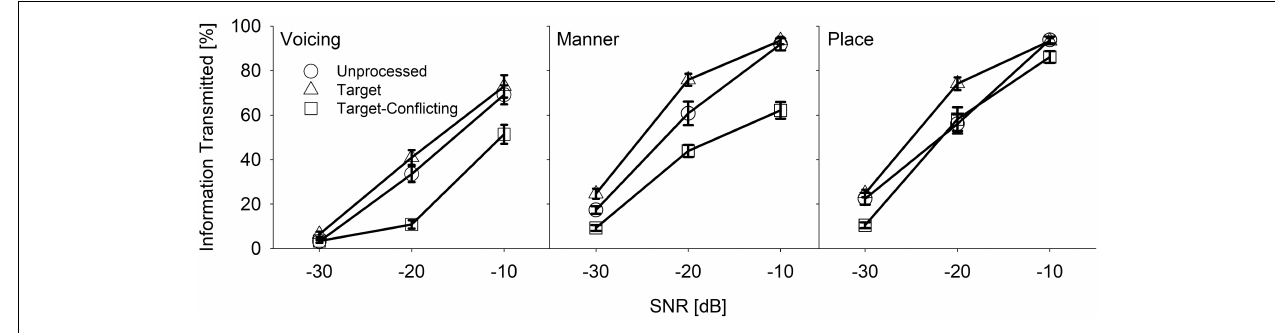
FIGURE 10 | Mean percent information transmitted for voicing, manner, and place as a function of SNR and of the signal processing.